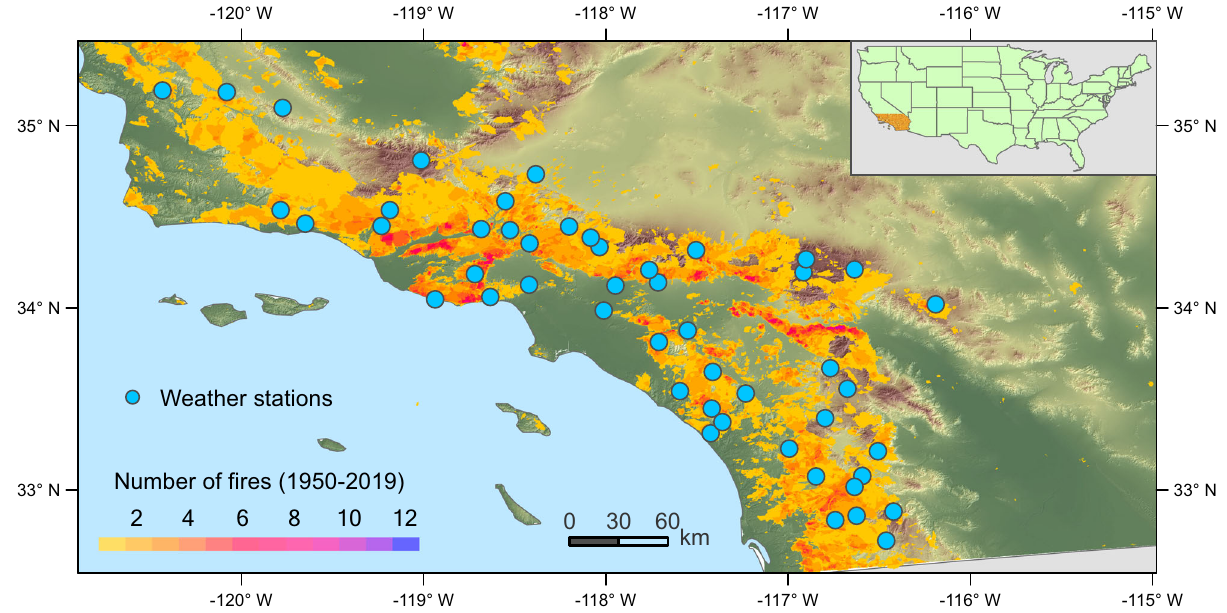
Fig. 1 Spatial domain of the study and the recorded total number of fi res since 1950. Blue dots refer to the locations of the weather stations used for this study. Fire perimeter data are derived from the California Department of Forestry and Fire Protection